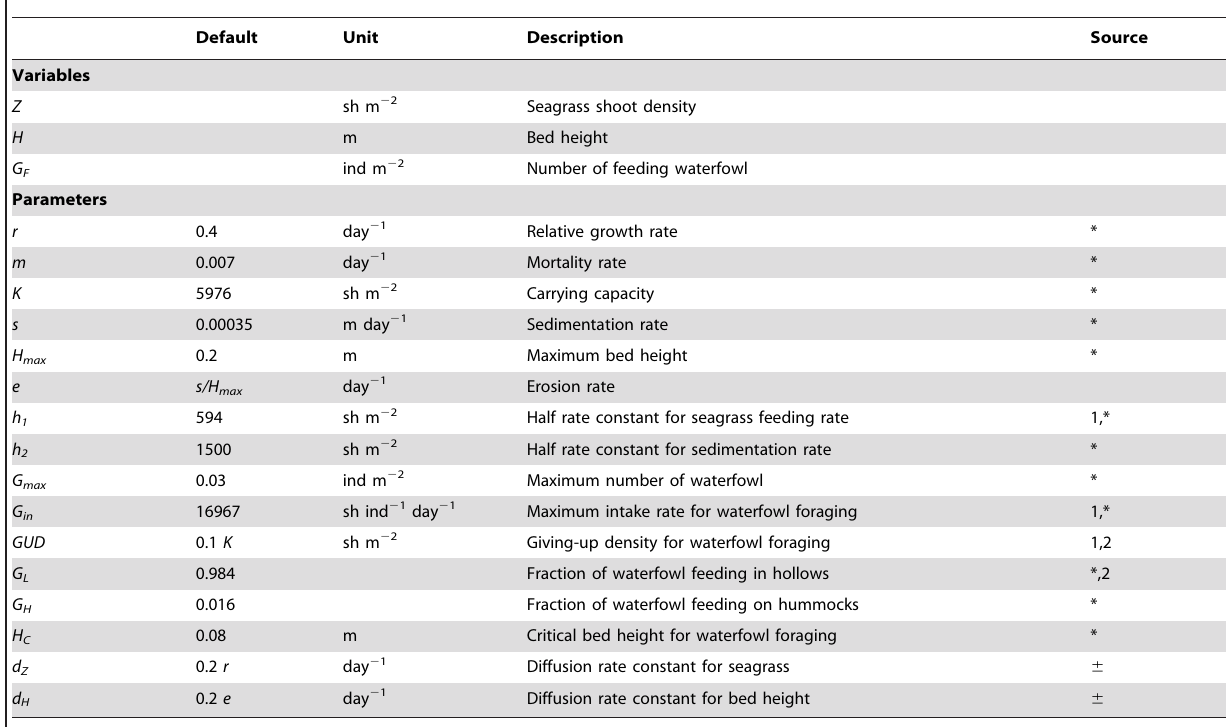
Table 1. Default parameter settings of the spatially explicit